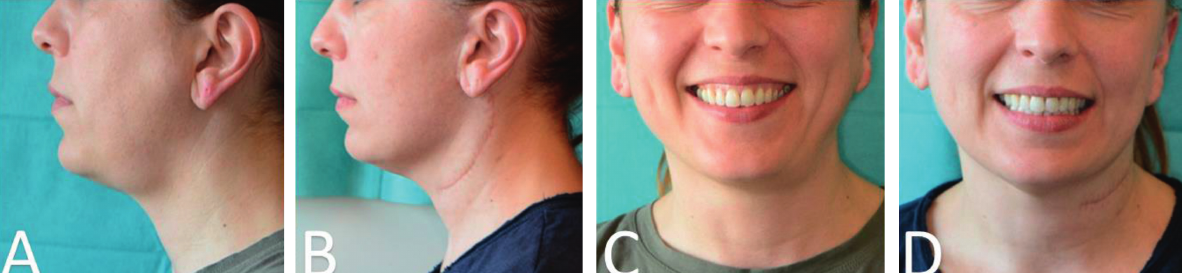
Figure 2: (a, c) Clinical view of ipsilateral swellings of left parotid and submandibular regions; (b, d) 3-month follow-up clinical